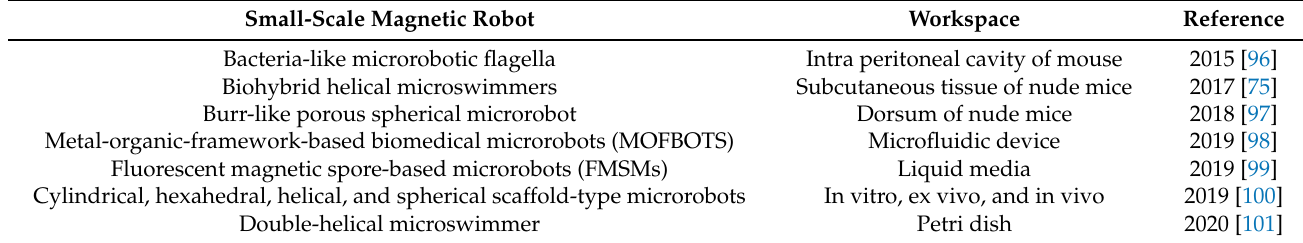
Table 4. Exemplar studies of small-scale magnetic robots with fluorescence imaging